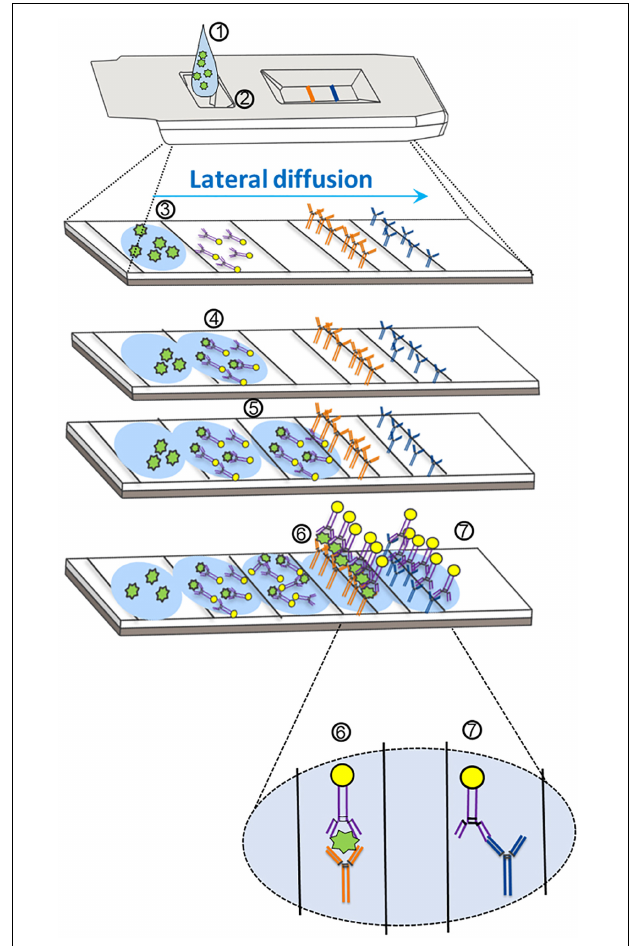
FIGURE 1 | Mechanism of action for severe acute respiratory syndrome coronavirus-2 (SARS-CoV-2) antigen detection through lateral flow assay design. (1) The specimen analyte, containing SARS-CoV-2 antigen suspended in assay buffer, is deposited in the sample well (at 2). (3) The analyte (containing antigen; in green) is absorbed into the sample pad and begins to diffuse across the reaction chamber into the conjugate pad. (4) The analyte comes into proximity of a SARS-CoV-2-specific antigen antibody that is conjugated to a tag (usually consisting of gold, latex, or a fluorophore). (5) The antigen–antibody complex migrates via diffusion across the nitrocellulose membrane. (6) The SARS-CoV-2 antigen–antibody complex comes into proximity of a second SARS-CoV-2 antigen antibody (different epitope) that is covalently bound to the device pad, and an antibody–antigen–antibody complex forms, resulting in the test line. Further diffusion of excess SARS-CoV-2 antibodies (unbound to antigen) results in association of a second covalently bound antibody that is specific for the first SARS-CoV-2 antibody. (7) An antibody–antibody complex forms resulting in the control